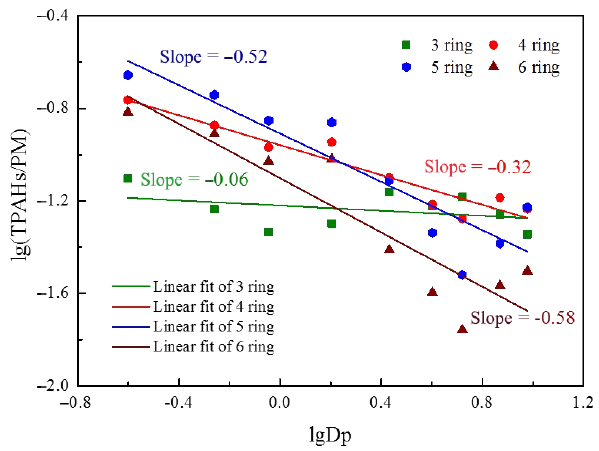
Figure 5. Plots of lg(TPAHs / PM) − lg( D p ) for PAHs with different ring numbers.